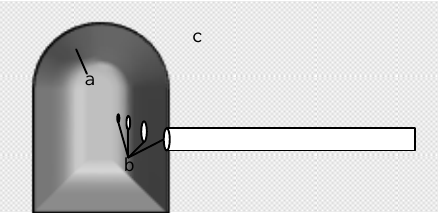
Figure 1. Schematic of gas extraction borehole ( a ) roadway; ( b ) gas extraction borehole; ( c ) coal